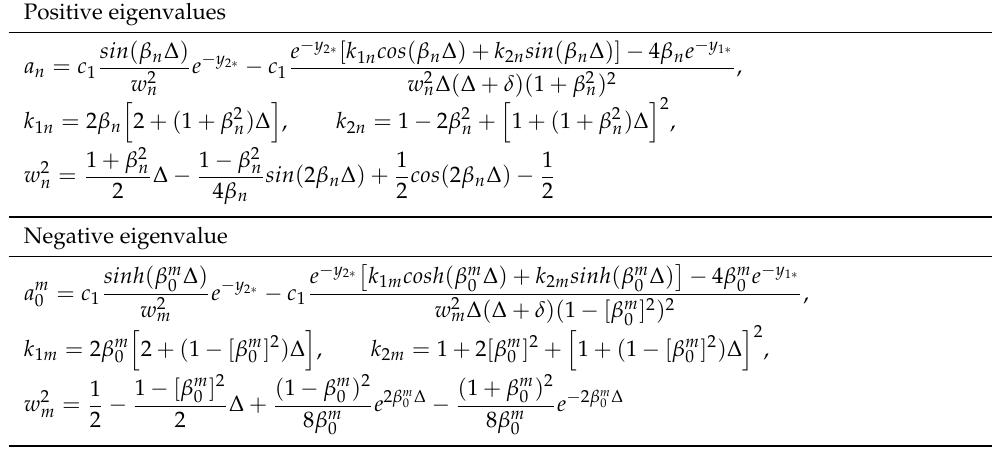
Table A1. Fourier coefficients a n and a m Positive